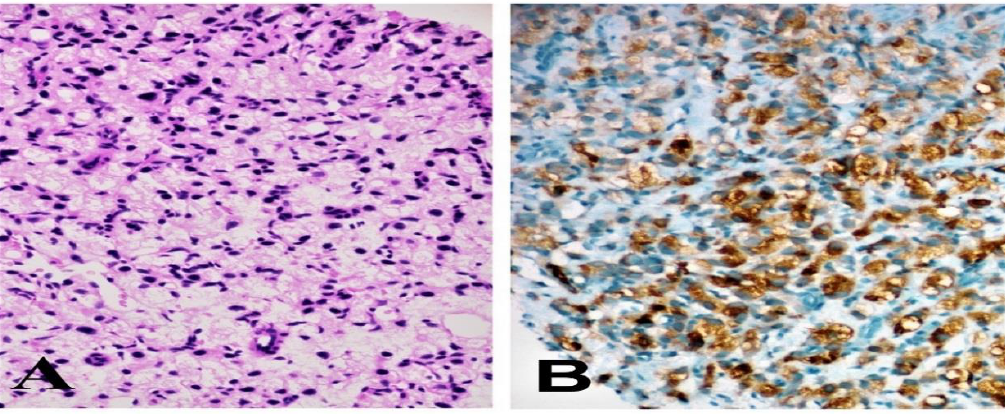
Figure 1. Specimen with hematoxylin and eosin staining of tumor cells (magnification ×200) ( A ); specimen staining positively for PSA (magnification ×200) ( B ).